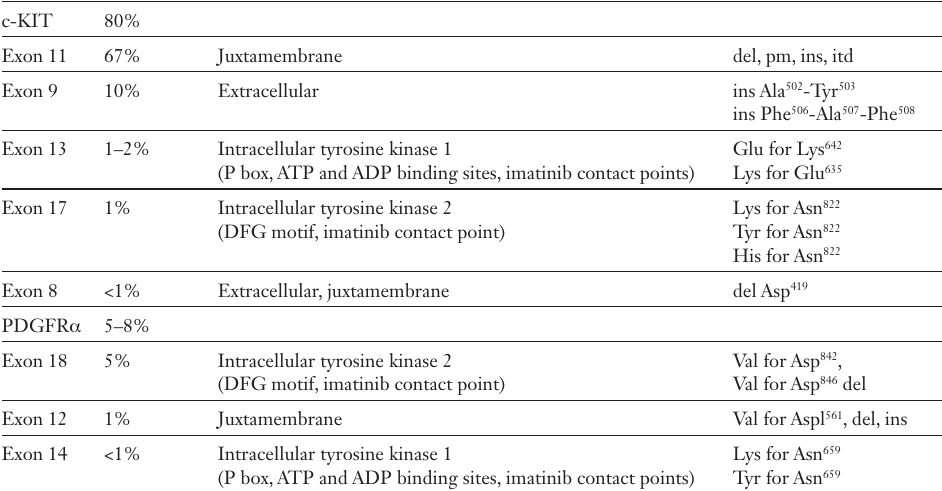
Frequency, location and type of muta- tions in GIST, ordered by frequency (del, deletion; ins, inser- tion; itc, internal tan- dem duplication; pm, point mutation) adapted from Lasota et al. 2008